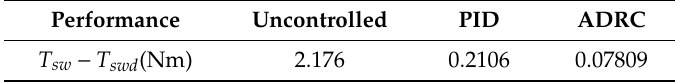
Table 3. The RMS comparison of the steering wheel torque tracking errors in lemniscate simulation.